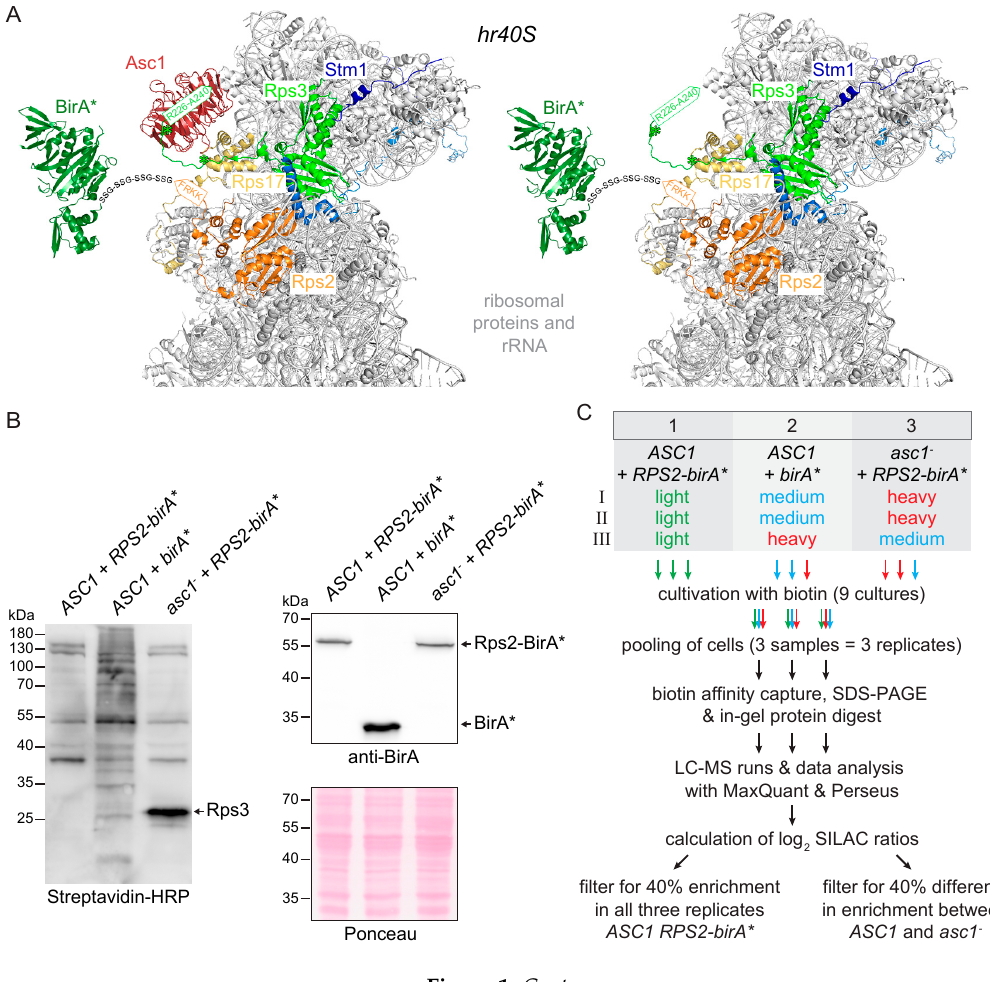
Figure 1. Set-up of the Rps2-BioID analysis. ( A ) Rps2-BirA* at the hr40S in the presence and absence of Asc1 (red). The BirA* protein (dark green) is fused to the C-terminus of Rps2 (uS5, orange) with a linker sequence consisting of four repeats of Gly-Ser-Ser (GSS). The last four amino acids of Rps2 (in orange letters) were structurally not resolved and are indicated within an orange arrow. Ribosomal proteins captured with Rps2-BirA * are highlighted in different colors: Rps17 (eS17) yellow, Rps3 (uS3) light green, Stm1 blue. Biotinylated lysine residues K212 and K223 of Rps3 are indicated with green asterisks (the green arrow indicates the last 15 C-terminal amino acids of Rps3 that were structurally not resolved). The PyMOL Molecular Graphics System software was used to generate the figures from crystal structure data of the S. cerevisiae 80S ribosome and the E. coli BirA protein derived from the PDB entries 4V88 [15] and 1BIB [45], respectively. ( B ) An aliquot of each SILAC-labeled culture was taken prior to cell pooling for cell lysis. Extracts were applied to SDS-PAGE and proteins blotted to a membrane. Streptavidin-HRP was used to detect biotinylated proteins (left), and a BirA-specific antibody was applied to detect the BirA* and Rps2-BirA* proteins (right). The birA* and RPS2-birA* alleles were expressed from extrachromosomal high copy number plasmids in the ASC1 wild-type and asc1 − background as indicated. Ponceau staining of the proteins on the membrane served as the loading control. Results are shown representatively for one of three replicates. ( C ) Strategy and workflow of the Biotin IDentification (BioID) experiment. Stable isotope labeling with amino acids in cell (SILAC) amino acids were used for a triple-labeling approach with three replicates (I-III), including a medium to heavy label swap. For detailed information about mass-spectrometry data acquisition (XCalibur) and analysis (MaxQuant and Perseus), see Materials and Methods and Table 3. ( D ) Drop dilution assays (successive 10-fold dilutions) in the presence of biotin or cycloheximide to test whether the additional expression of BirA* or Rps2-BirA* impairs colony growth. Strains transformed with the empty vector (EV) were used for growth controls. ( E ) Binding of biotinylated proteins on Strep-Tactin gravity flow columns. Equal volumes of the cell lysate (BioID input, applied on the Strep-Tactin column) and the flow-through were subjected to SDS-PAGE and proteins blotted to a membrane followed by detection of biotinylated proteins using streptavidin-HRP.